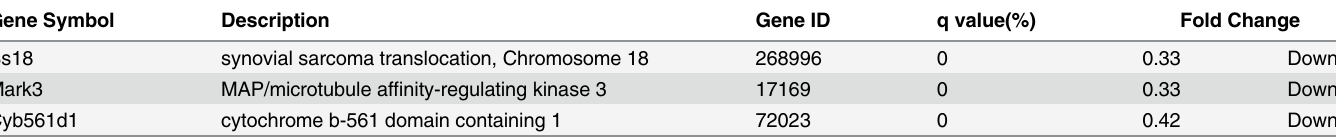
Table 3. Differentially expressed genes in WTL vs WNL group.